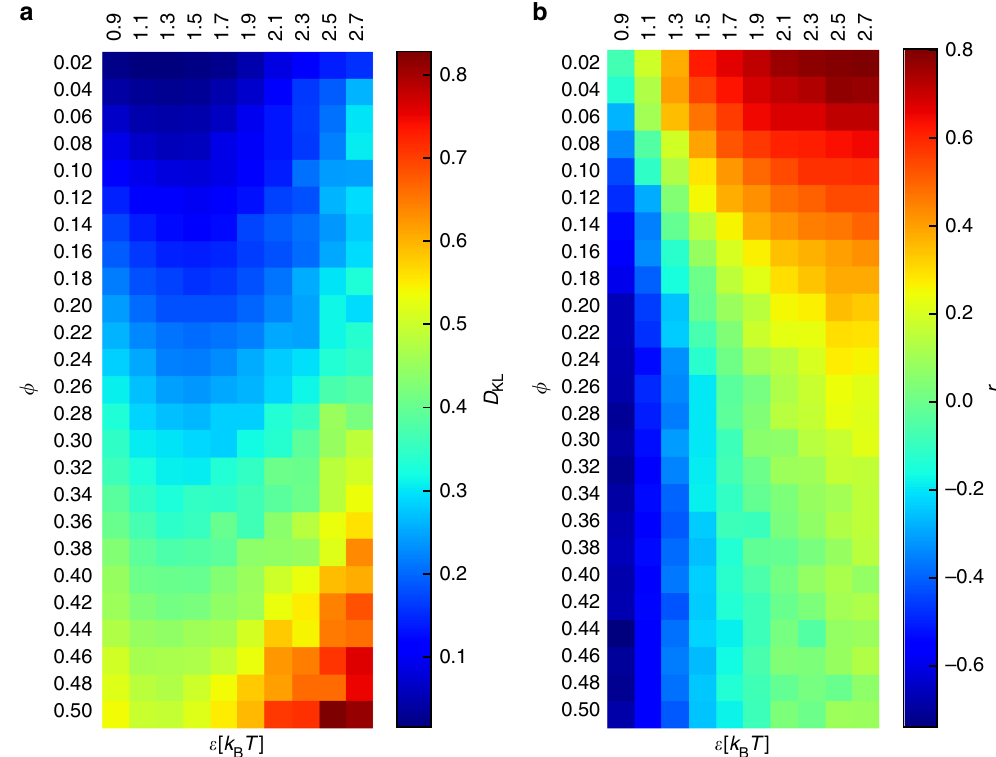
Fig. 3 Coincidence of the traf fi c of the tracers with the contacts of the polymers. Average values of the Kullback – Leibler divergence ( a ) and of the Pearson correlation coef fi cient ( b ) for different model parameters. Calculations were performed as described in Methods